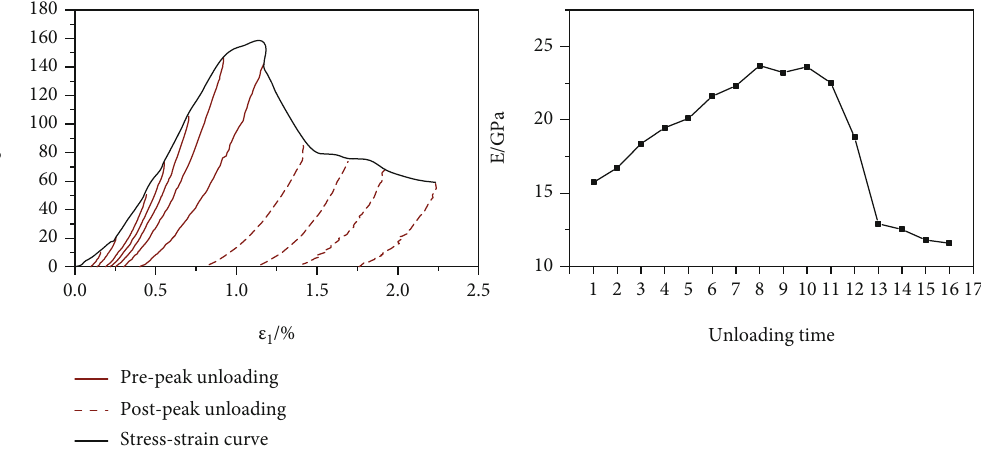
Figure 5: Unloading curves and evolution of elastic modulus under 10MPa con fi ning pressure.